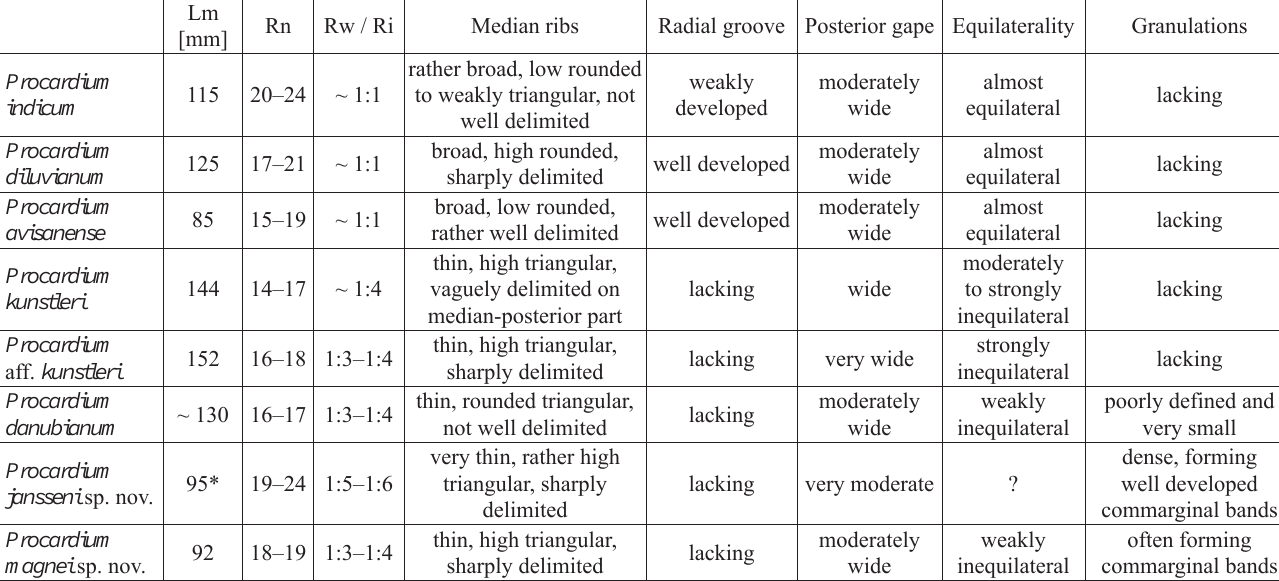
Table 2. Comparative shell characters for Procardium taxa. Lm, maximum shell length in the study material (* estimated); Rn, number of radial ribs (excluding secondary riblets); Rw/Ri, rib width to interspace width ratio on median shell region; median ribs, characters of ribs on median shell region; radial groove, characters of rib groove on median shell region; posterior gape, width of posterior shell gape; equilaterality, degree of shell equilaterality; granulations, occurrence and distribution of granulose microsculpture in radial